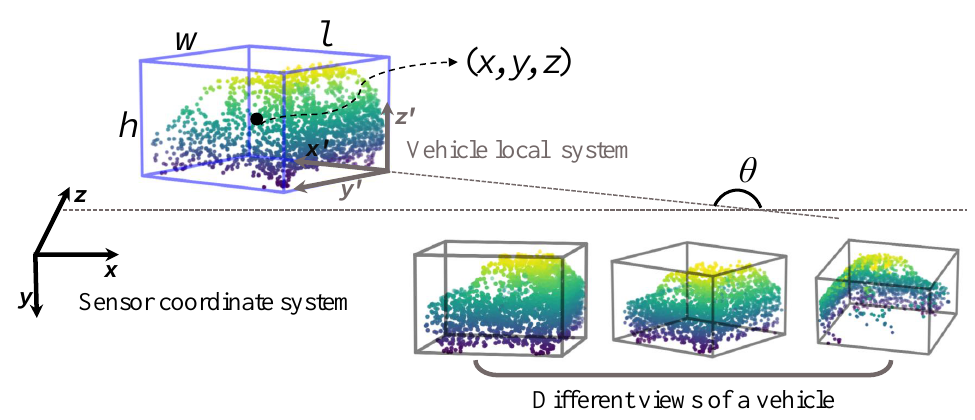
Figure 2. Object state representation in the sensor coordinate system. An object can be encompassed with a 3D bounding box (blue). Therein, ( x , y , z ) represents the object center location in the LiDAR coordinate system. ( h , w , l ) are the height, width, and length of object, respectively. θ is the radian between the motion direction and x-axis. The right-bottom also exhibits different views of object point clouds produced by